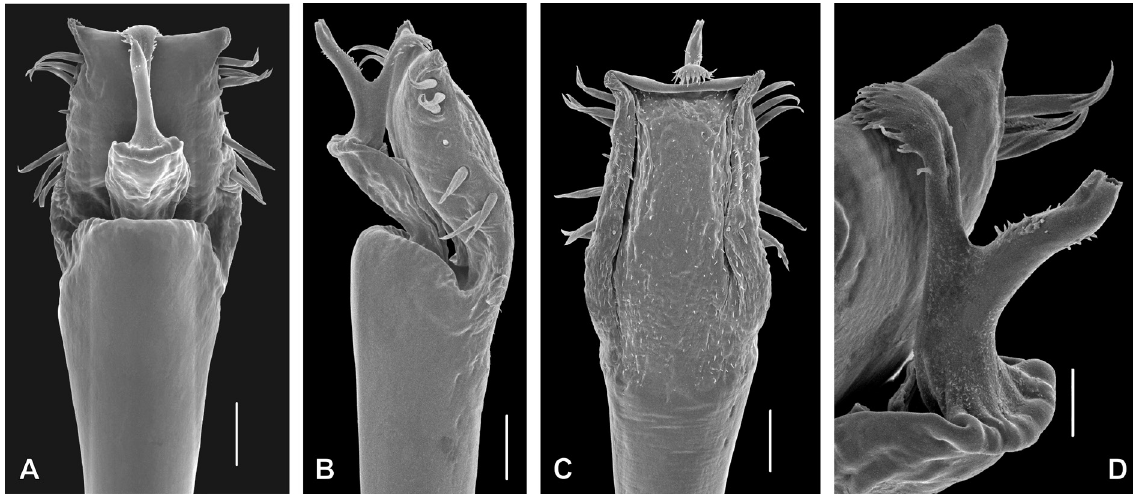
Fig. 11. Lacronia ceci Kury & Orrico, 2006, ♂ (MNRJ 6945 ꜝ ), penis, distal part. A . Dorsal view. B . Lateral view. C . Ventral view. D . Detail of stylus and ventral process, latero-dorsal view. Scale bars: A–C = 50 μm; D = 20